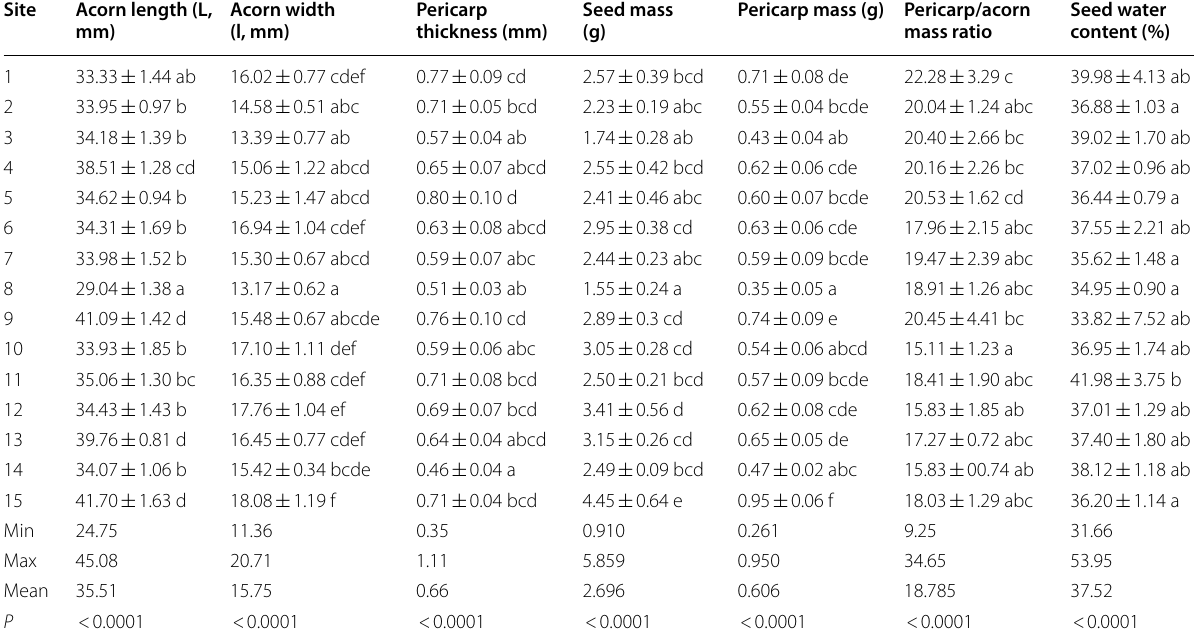
Table 2 Variation in morphological traits of seeds and acorns among the 15 Tunisian Holm oak populations studied. Differences between populations were tested using one‑way ANOVA and post hoc Bonferroni test form comparison of means. Two means displaying no letters in common are significantly different ( P <